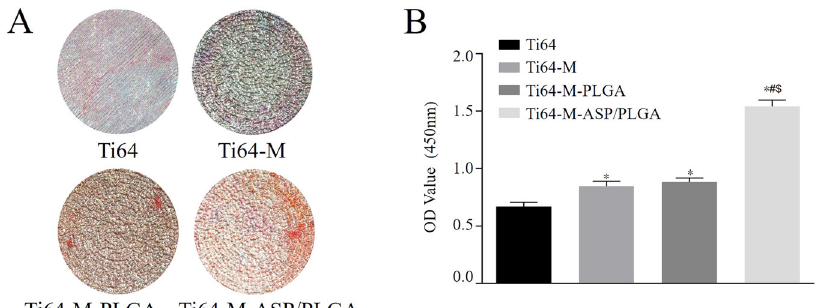
Fig. 6 In vitro Alizarin red S staining in MC3T3-E1 cells cultured with different samples. A Alizarin red S staining and B Quantitative analysis after 21 days of culture. Data are expressed as the mean ± standard deviation ( n = 3). ∗ , #, and $ indicate statistical signi fi cance p <